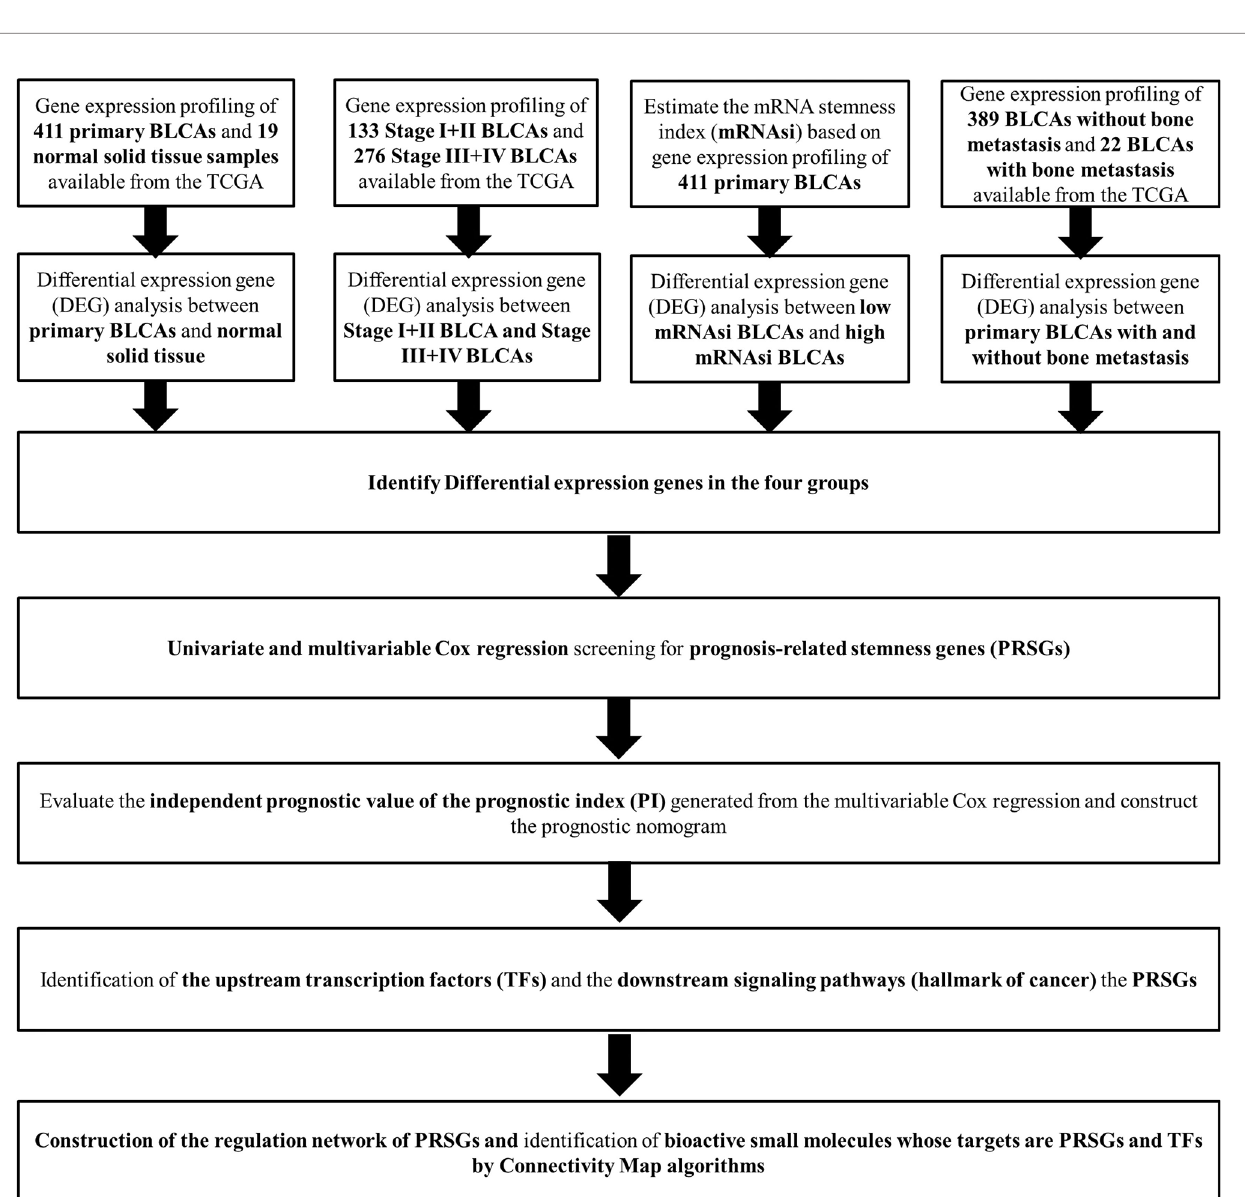
FIGURE 1 | The fl owchart of all analysis